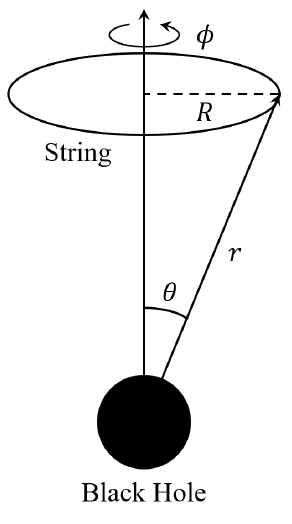
Figure 7 . An oscillating ring string moves along the axis of a black